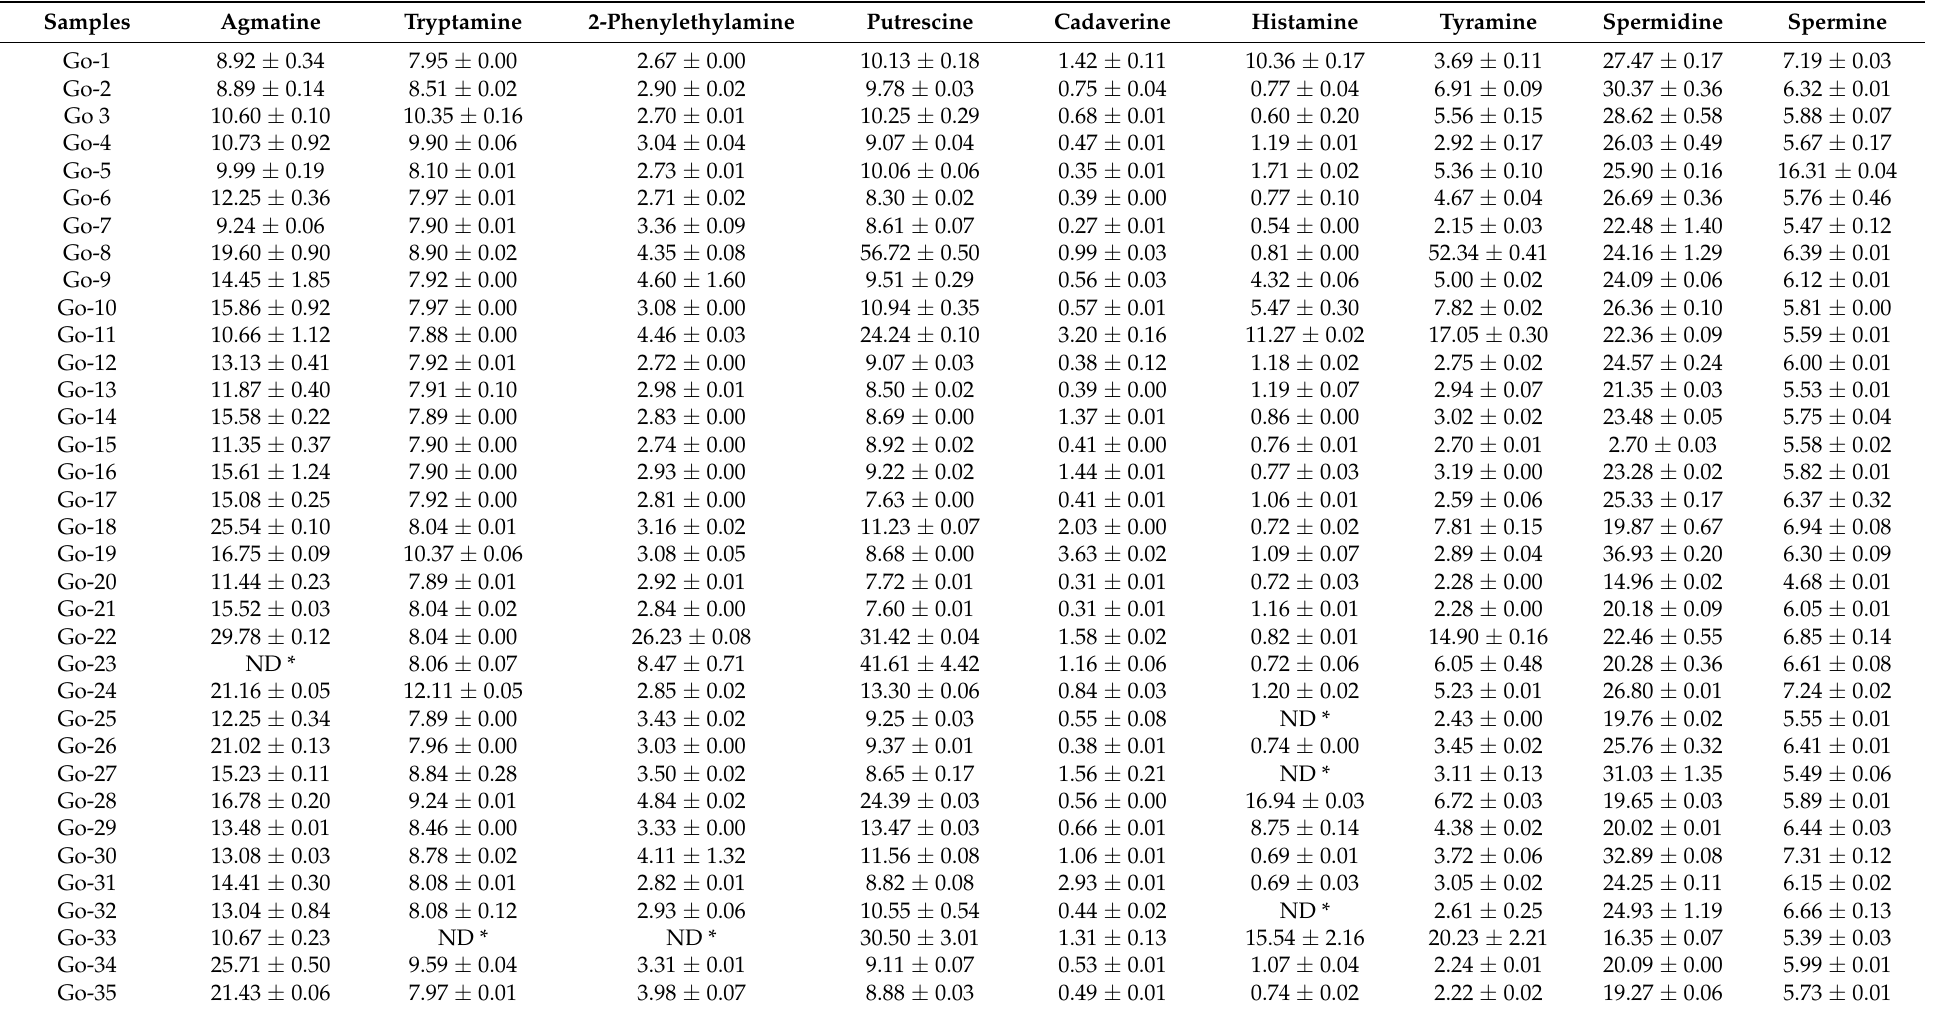
Table 2. Quantity of different biogenic amines (mg/kg) in the 35 gochujang products from the traditional cottage